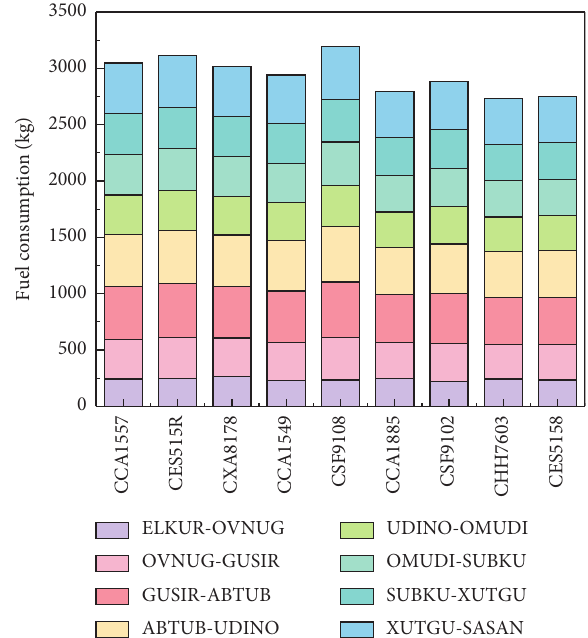
Figure 8: The fuel consumption of studied flights in each segment. Table 2: Numerical results for studied flights in terms of fuel consumption, gas emissions, and generated greenhouse effect. Flight